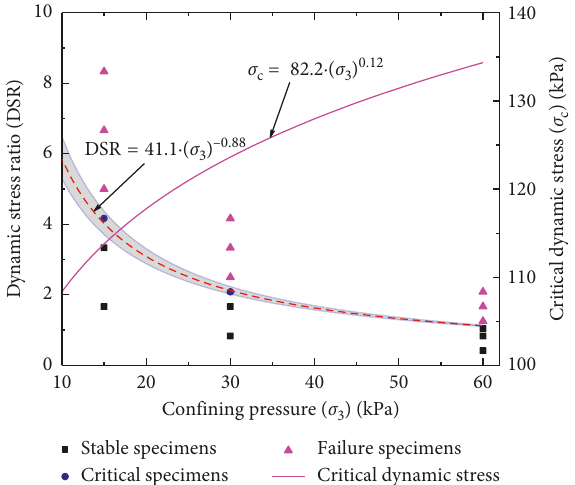
Figure 12: Cyclic stress ratio and critical dynamic stress versus confining pressure.